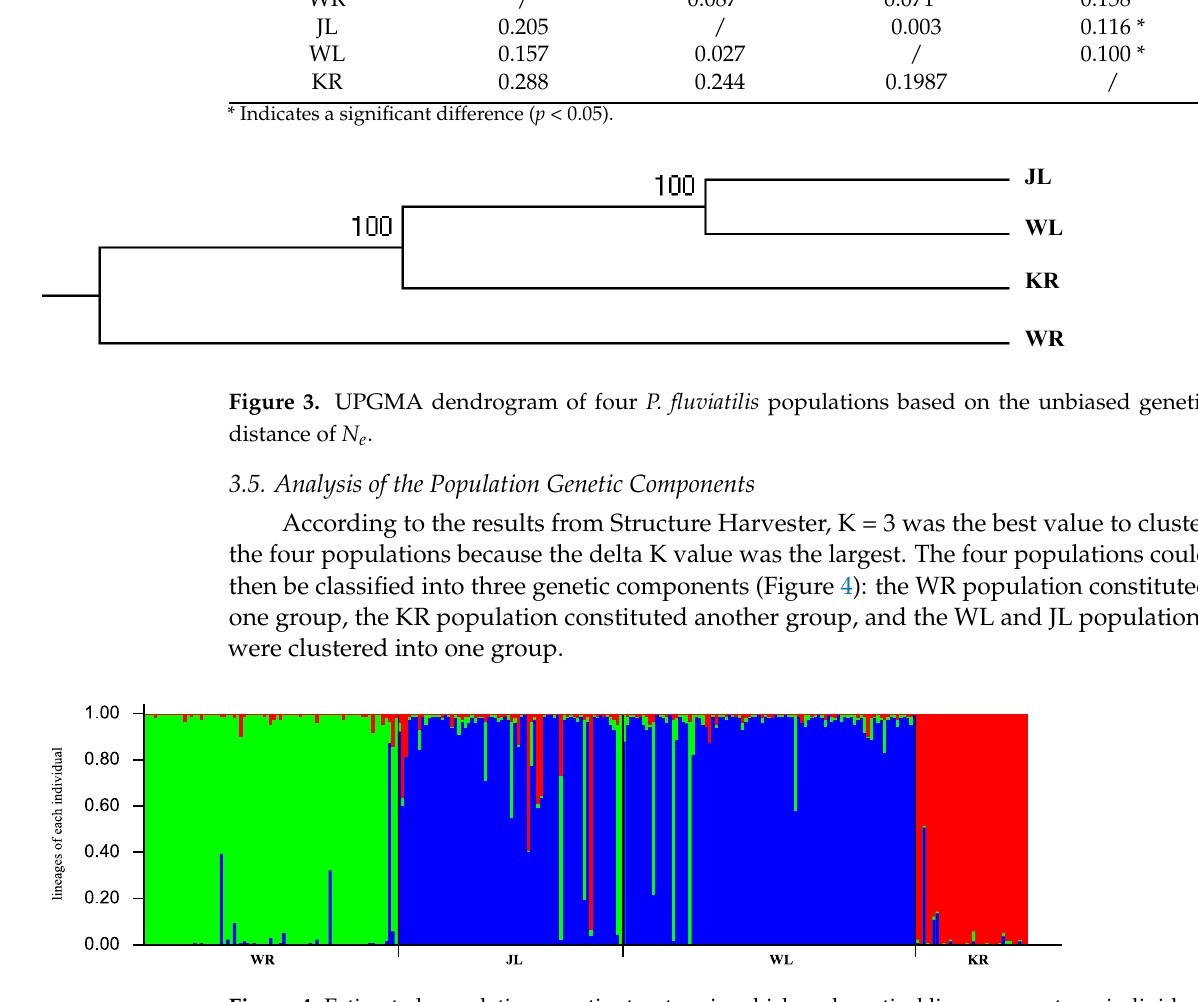
Figure 4. Estimated population genetic structure in which each vertical line represents an individual, different colors represent different genetic components, and the populations are separated by black lines (K = 3). The populations are labeled below the figure.